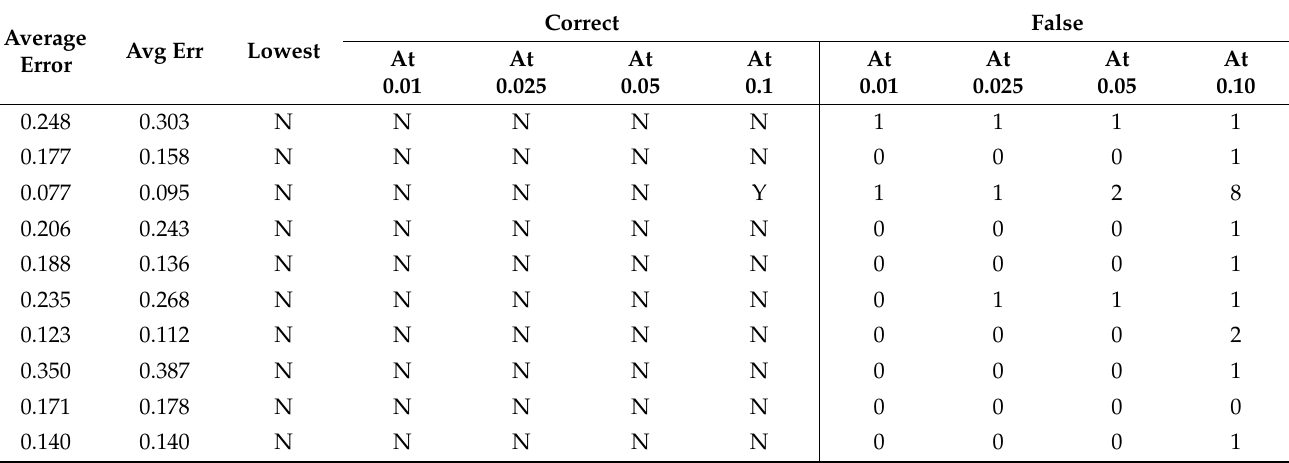
Table A185. Set 3, trials 11–20 summary data (average actual PR